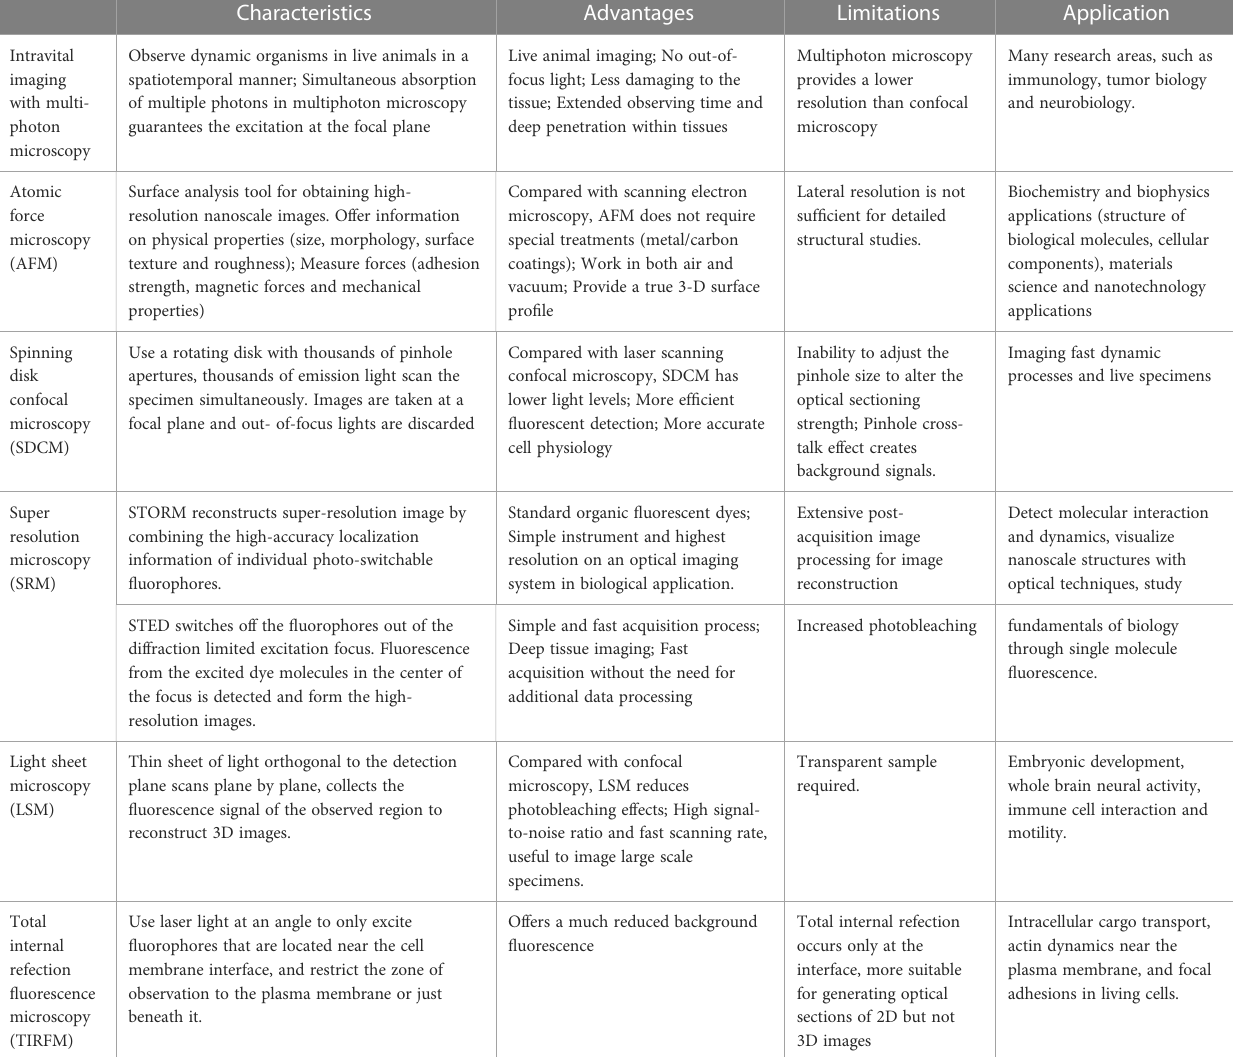
TABLE 1 Characteristics and application of advanced imaging